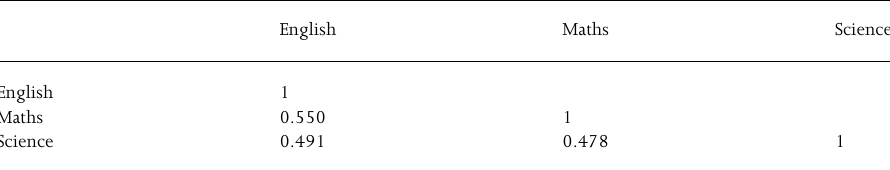
Table 7 The correlations of individual success across